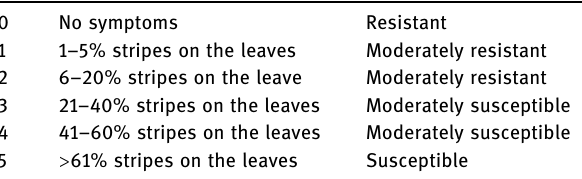
Table 1: Treatment layout for the evaluation of disease severity index as well as foliar application of AgNPs in experiment